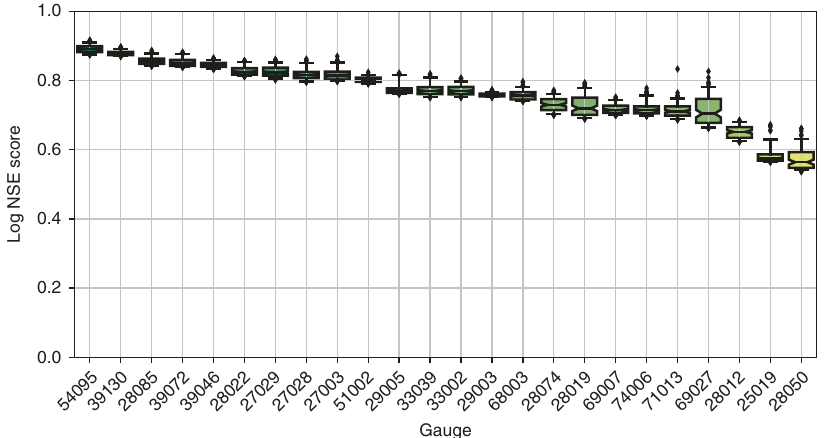
Fig. 7 Boxplots of the log Nash – Sutcliffe ef fi ciency performance of the DECIPHeR hydrological model. Results are shown at each gauge compared with observed fl ows, for the top 100 parameterisations out of 10,000 per gauge. Boxplot notch is the median, the bar is the inter-quartile range (IQR), whiskers extend to 5th and 95th percentiles, dots are outside this